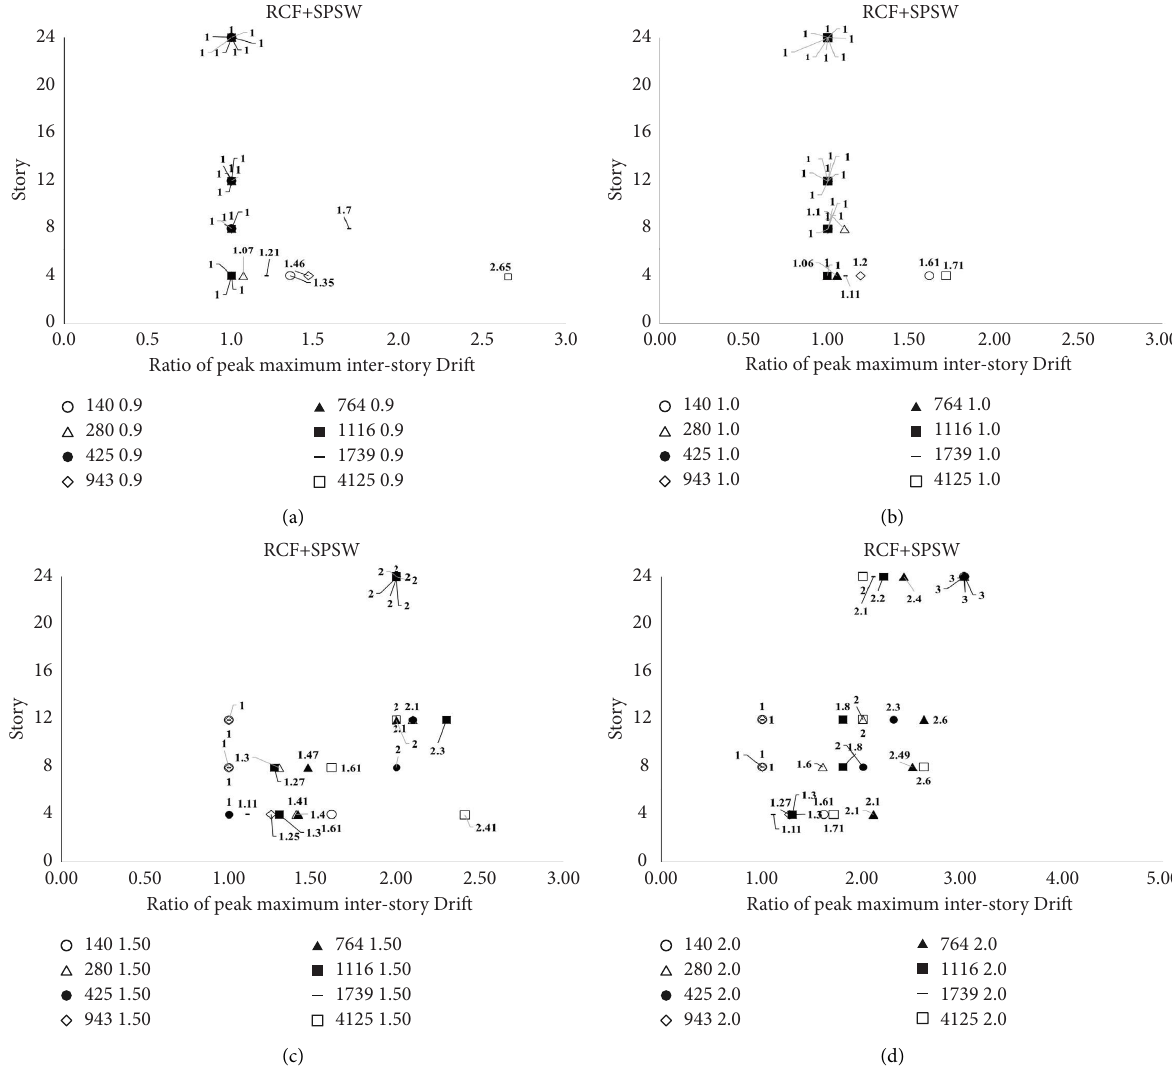
Figure 20: Ratio of peak maximum of interstory drift demand for artifcial seismic of models to MS demands of S1 and S3 scenarios in RCF with SPSW: (a) Scale 0.9, (b) scale 1, (c) scale 1.5, (d) scale 2.